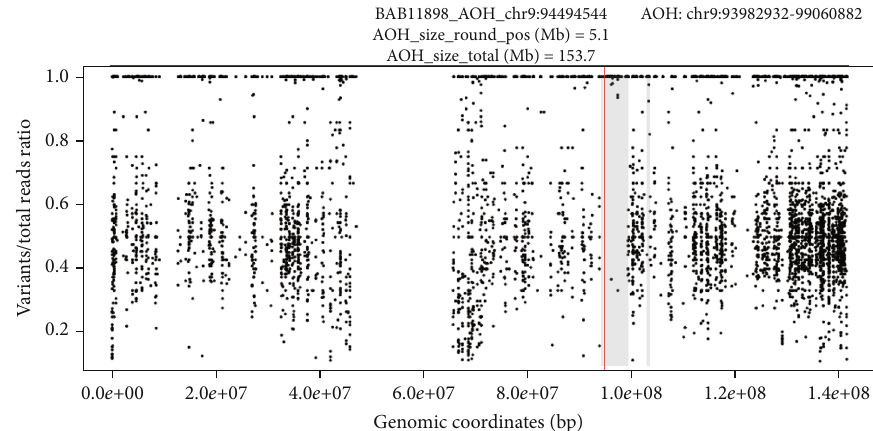
Figure 4: Absence of heterozygosity (AOH) plot shows the deletion within a 5.1Mb region that suggest identity by descent (IBD) and consistent with AR